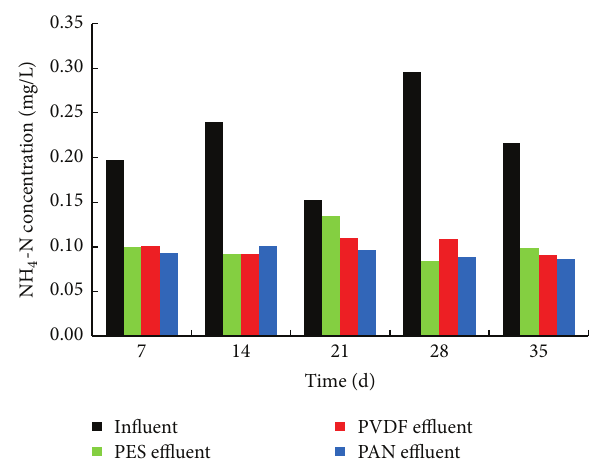
Figure 4: NH 4 -N concentration trend of UF filtrate during the test